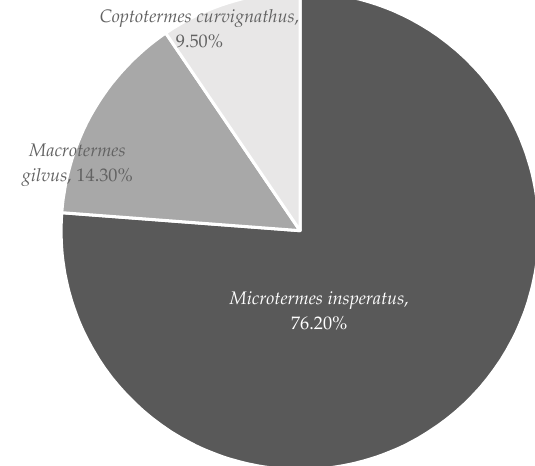
Figure 3. Percentages of subterranean termites represented in South Jakarta.